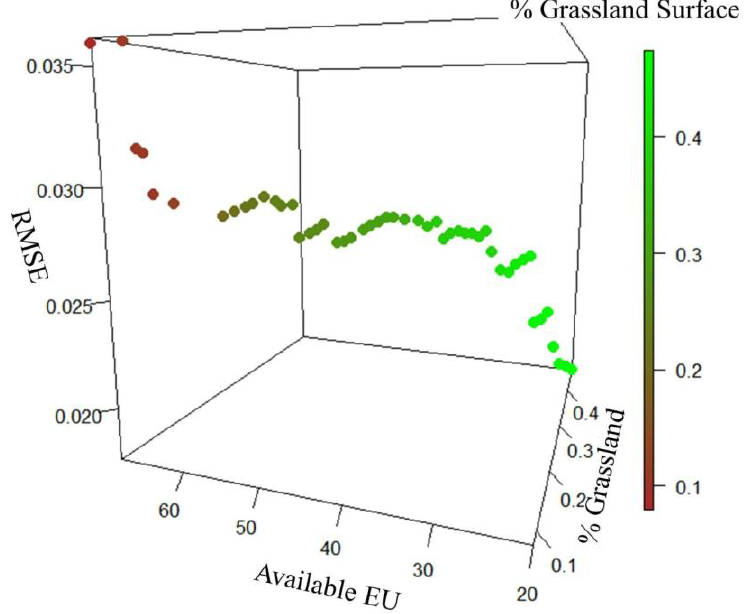
Figure 11. Root Mean Square Error of the linear regression for 2014 between ΔFPI MR and ΔFPI HR (Y-axis) according to the percentage of grassland surface in the ESU (Z-axis) and the available ESUs for the analysis according to the grassland surface threshold